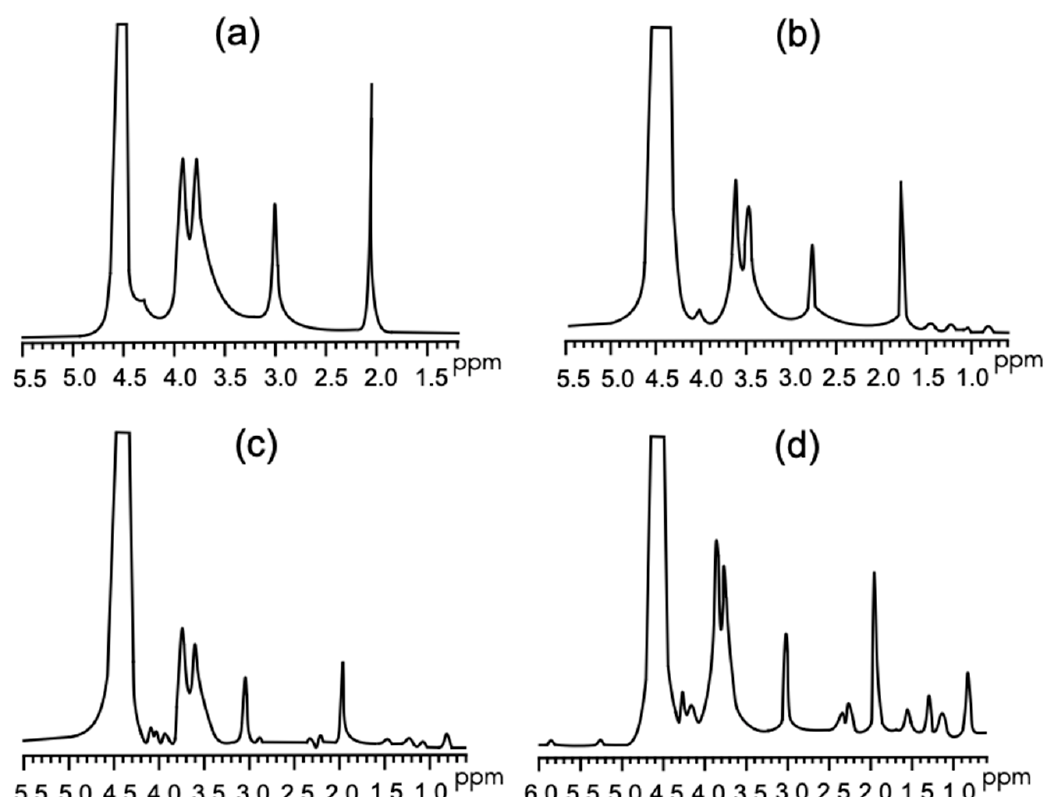
Figure 5. 1 H NMR spectra of chitosan (CH) and squid gelatin hydrolysates (SGH) films: ( a ) 100 CH/0 SGH, ( b ) 90 CH/10 SGH, ( c ) 80 CH/20 SGH, and ( d ) 60 CH/40 SGH.